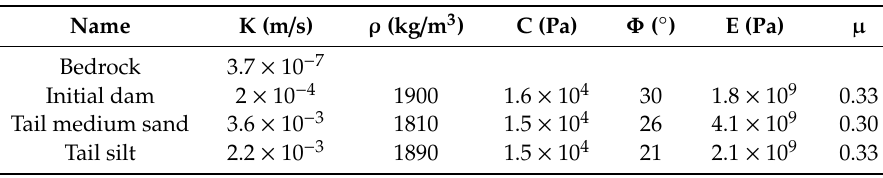
Table 1. The material properties of the di ff erent parts.